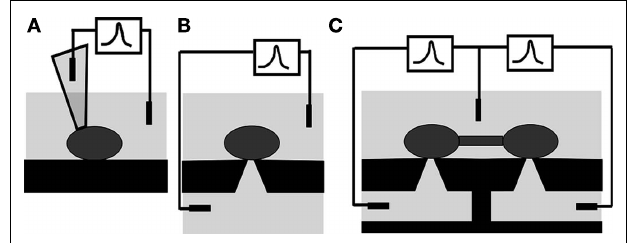
FIGURE 1 | Patch-clamp interrogation of neurons. (A) Conventional glass pipette. (B) Patch-clamp chip, with the tip of the pipette replaced by a micro-aperture in a self-supported film separating two baths. (C) Patch-clamp array chip, where several micro-apertures are etched in the self-supported film and the bottom bath is subdivided in microfluidic channels, one dedicated to each aperture.This novel structure can simultaneously interrogate cells in network communication.Taken from Py et al.